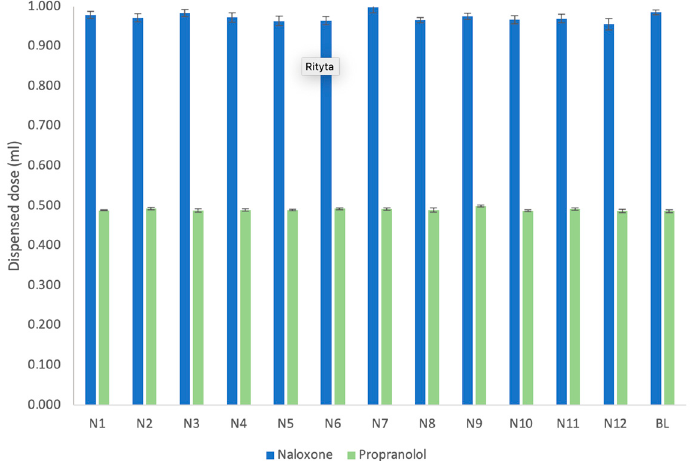
Figure 2. Dispensed dose (dosing accuracy) of formulations containing naloxone (blue) and propranolol (green). BL = baseline (original composition). Compositions of formulations N1–N12 according to Tables 4 and 5. Mean value with 95% confidence interval (n = 10). The target dose was 1 mL (corresponding to 1 mg naloxone) and 0.5 mL (corresponding to 5 mg propranolol). ±10% of the target dose was considered an acceptable dosing accuracy.